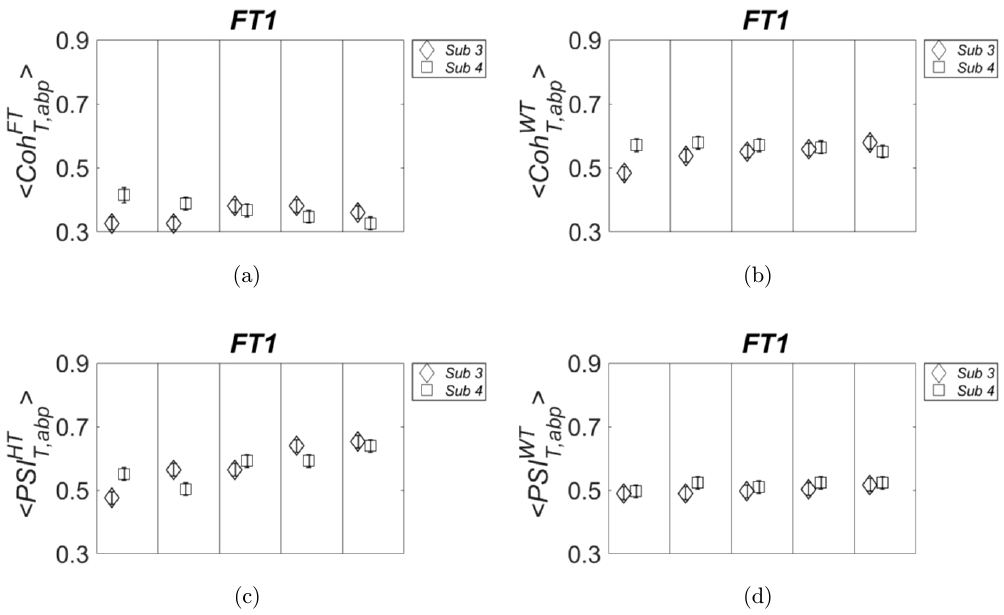
i (panel (a)), h Coh WT i (panel (b)), h PSI HT i T ; abp T ; abp abp